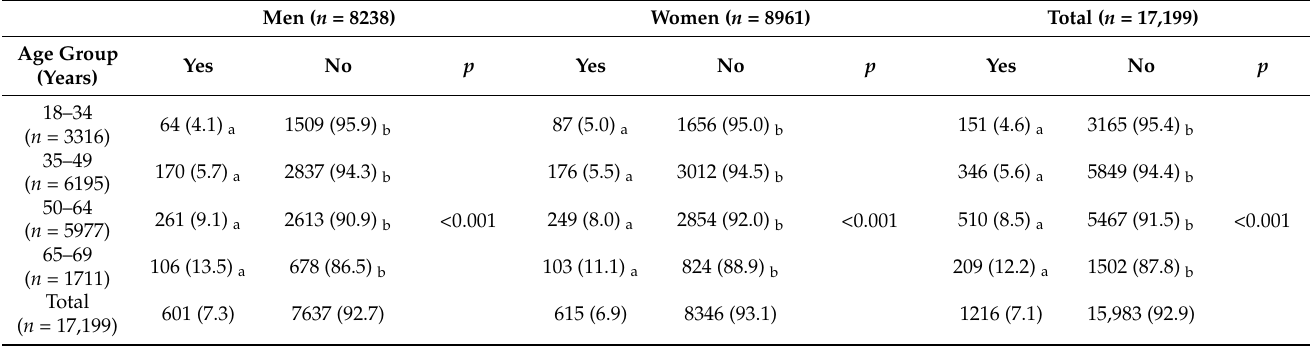
Table 2. Age group relations and the hospitalisation prevalence in the general Spanish population aged 18–69 years, compared by sex, according to the ENSE